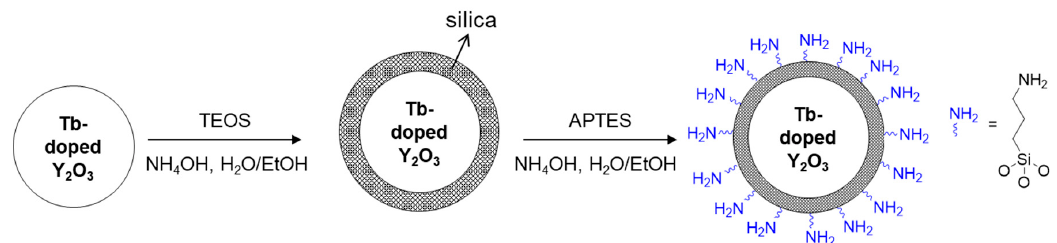
Figure 9. Schematics of silica shell formation and functionalization with aminopropyl groups on the surface of Y 2 O 3 :Tb 3 + nanoparticles produced by salt-assisted FSP.